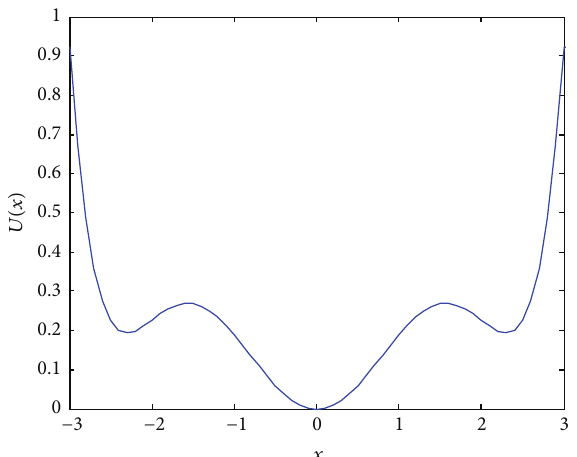
Figure 1: The multistable potential function 𝑈(𝑥) .